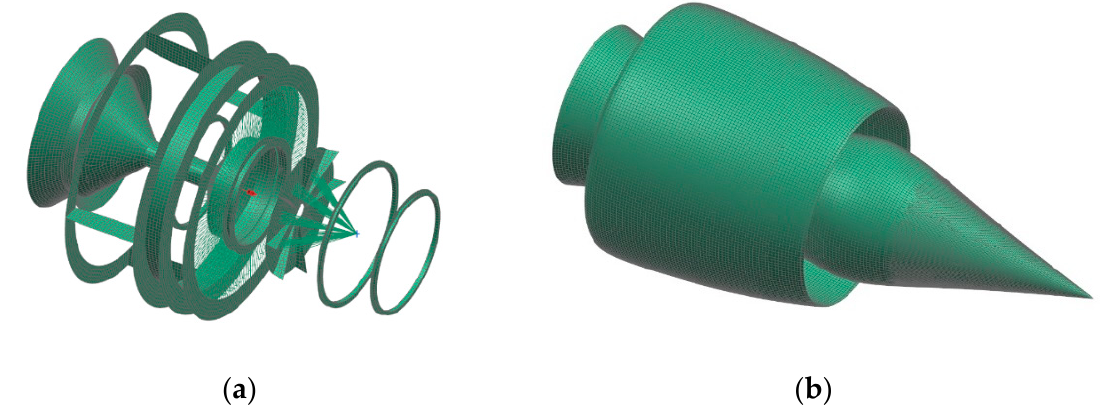
Figure 24. Finite element mesh for ( a ) internal structure and ( b ) skin of the aft-fuselage